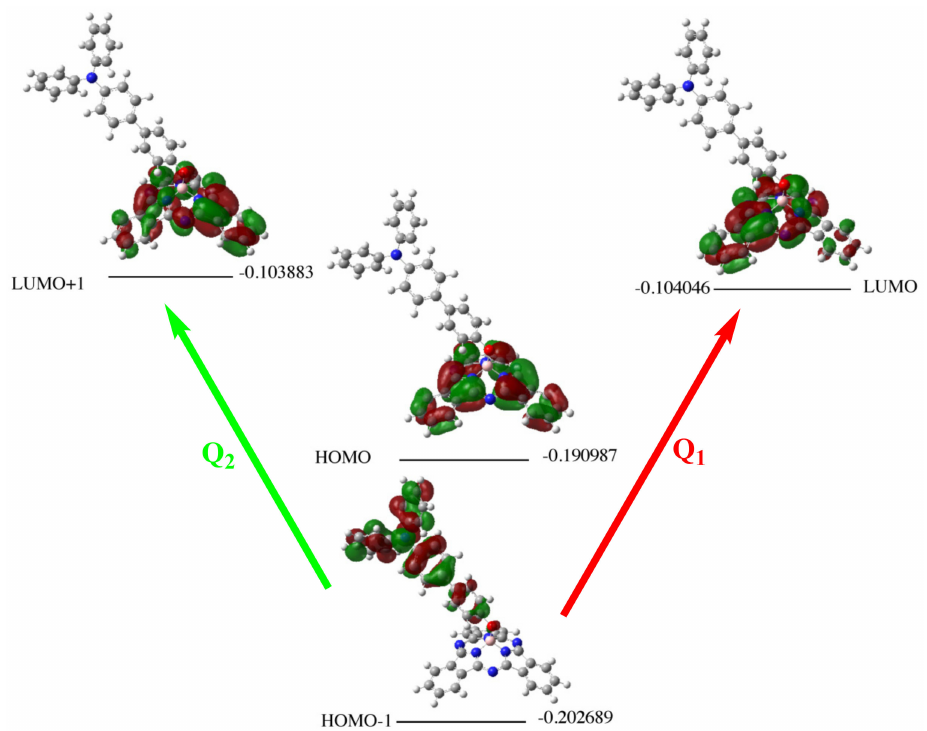
Figure 5. MO diagram showing, for SubPc(A2,H,H,H), the main transitions Q 1 and Q 2 contributing to the Q band, which are accompanied by a charge transfer phenomenon. Molecular orbital energies are in